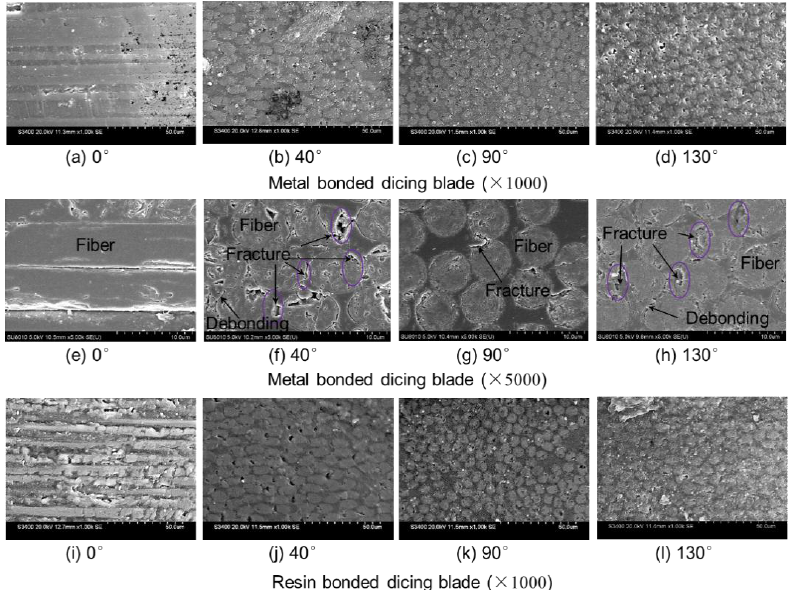
Figure 12. Surface morphologies of CFRP composites after dicing with different fiber orientation.